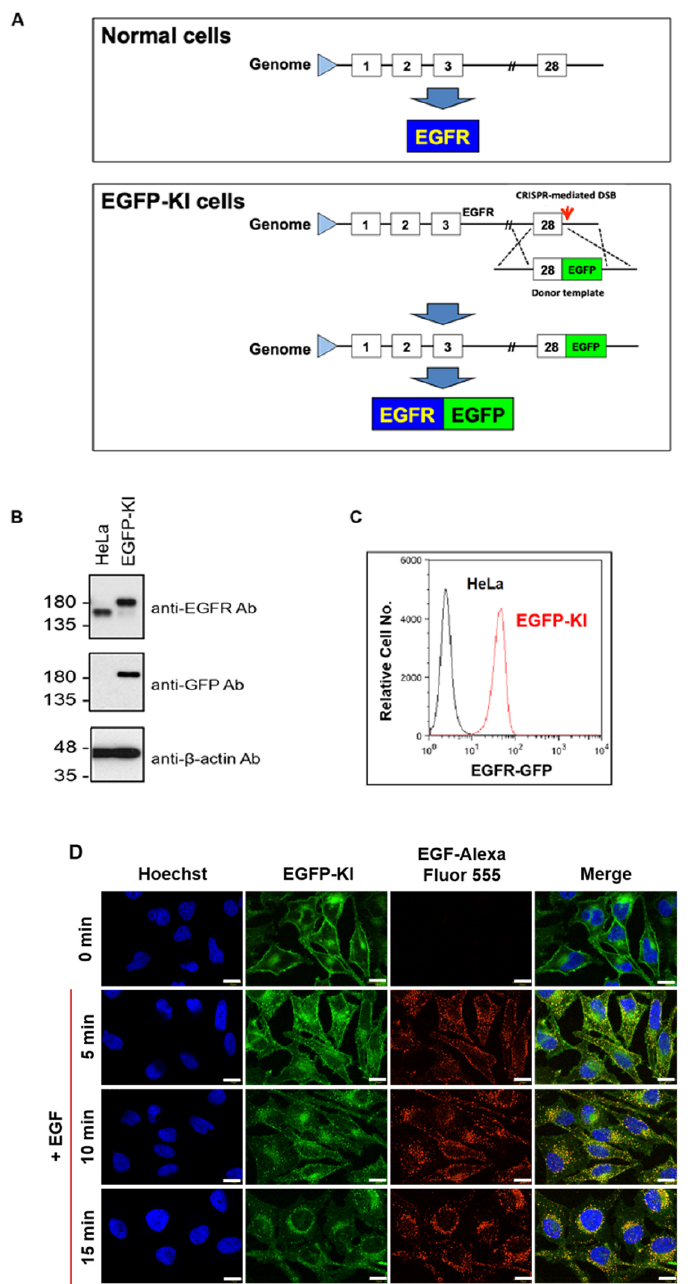
Figure 2. Construction of CRISPR/Cas9-mediated EGFP-KI HeLa cells. ( A ) Schematic representation of the EGFR-GFP construct with a knock-in EGFP segment at the C-terminus. Boxes represent EGFR exons and the number indicates the exon numbering; ( B ) Western blot analysis of EGFR-GFP in EGFP-KI cells against EGFR and GFP; ( C ) Flow cytometry analysis of the EGFR-GFP fluorescence intensity; ( D ) Time-course fluorescence images of EGFP-KI cells upon treatment with 100 ng/mL EGF at 37 °C for up to 15 min. Scale bar, 20 µm.